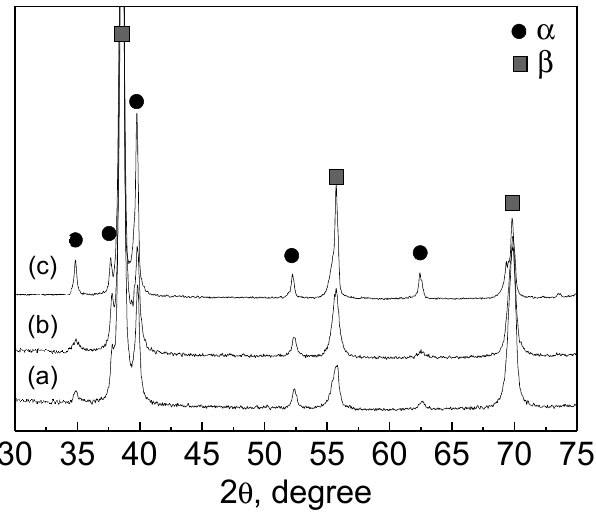
Figure 4. XRD profiles of the alloys after heat treatment: ( a ) 2Zr-4O alloy; ( b ) 2Zr-6O alloy; ( c ) 2Zr-10O alloy.